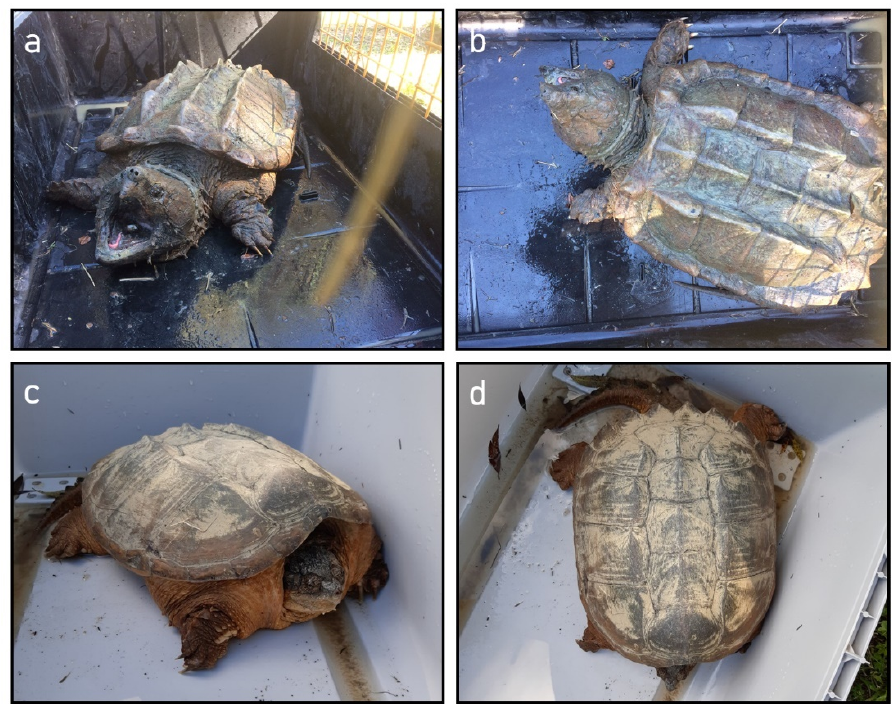
Figure 2. Adult individuals of the alligator snapping turtle ( Macrochelys temminckii ) ( a , b ) and the snapping turtle ( Chelydra serpentina ) ( c , d ) from Lake Lucinasco (Liguria, Italy): ( a , c ) front view and head detail; ( b , d ) top view with detail of the carapace. Photo courtesy of Vasco Menconi ( a , b ), and Manuel Maggioli ( c , d ).